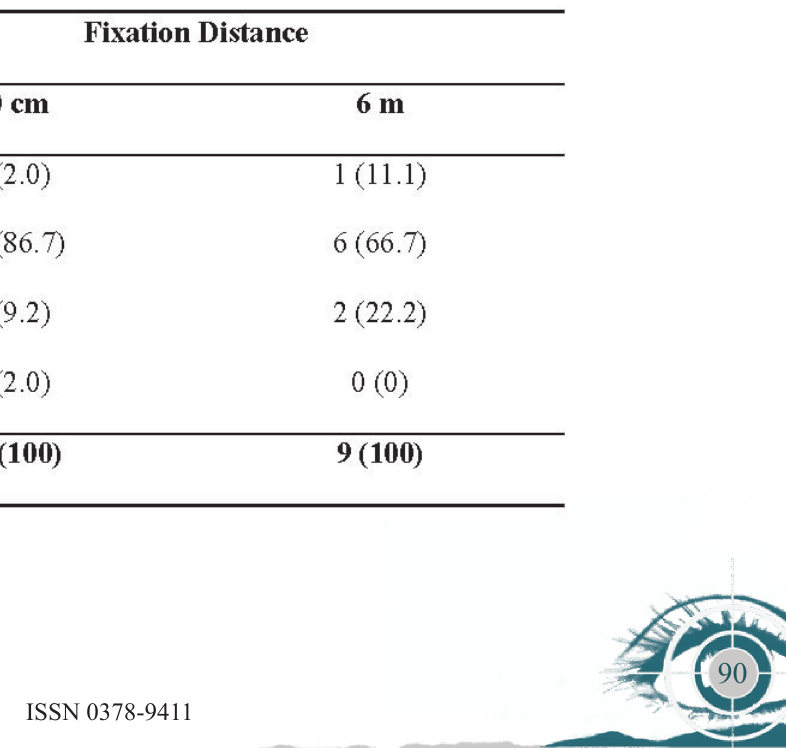
Table 3: Distribution of Ocular